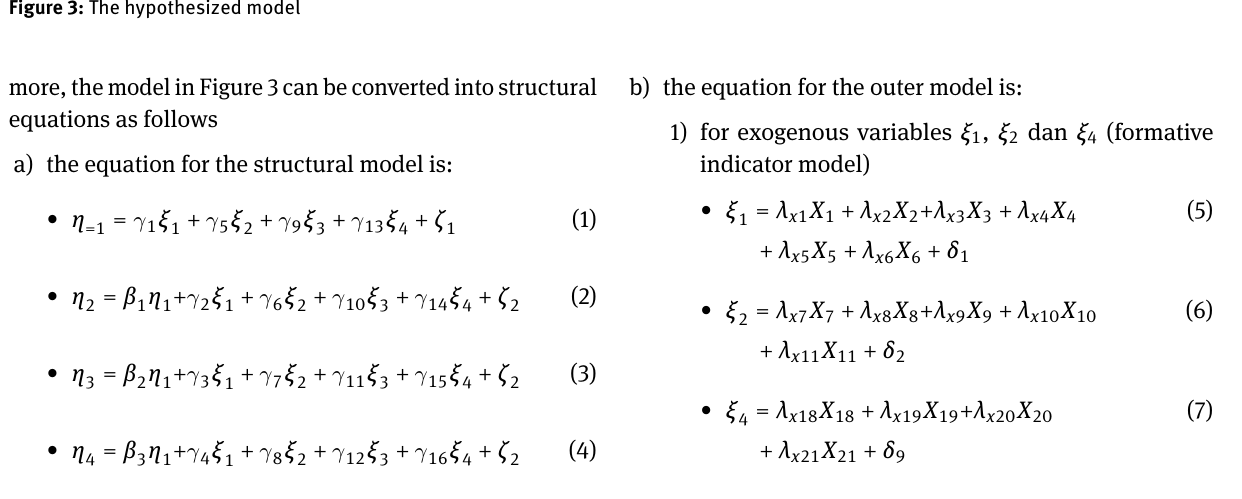
Figure 3: The hypothesized